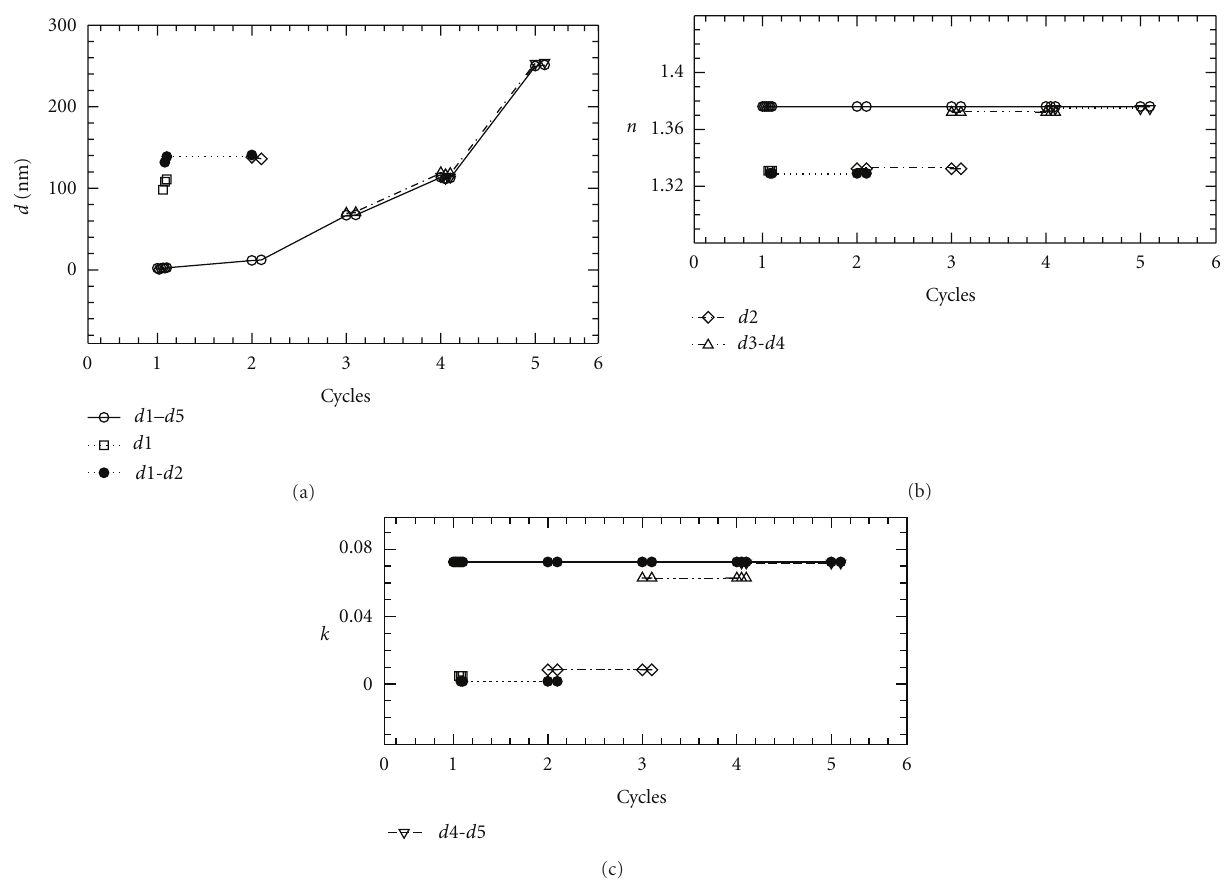
Figure 8: Calculated thickness, d , and optical indices, n , k , for the Ppy layers already described in Figure 3(b). Ea = 1.4V, τ = 15 s. SDS solution, λ = 546 nm. The di ff erent values n and k correspond to the resulting fitted values for di ff erent set of